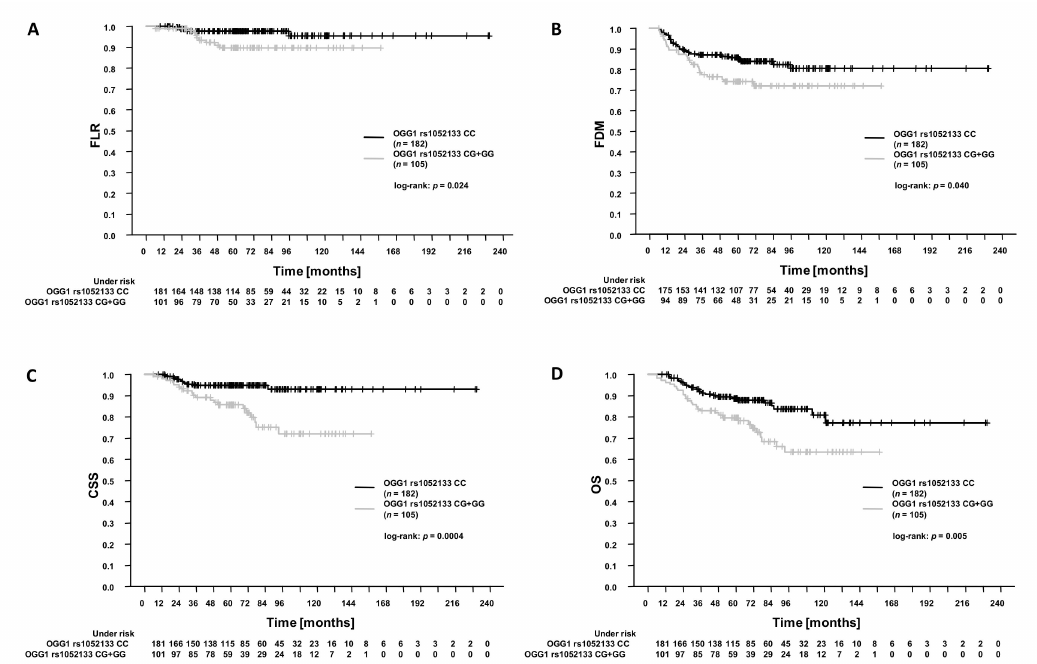
Figure 3. Kaplan-Meier plots for FLR ( A ), FDM ( B ), CSS ( C ), and OS ( D ), depending on the OGG1 rs1052133 polymorphism. Differences by genotype were statistically assessed by the log-rank